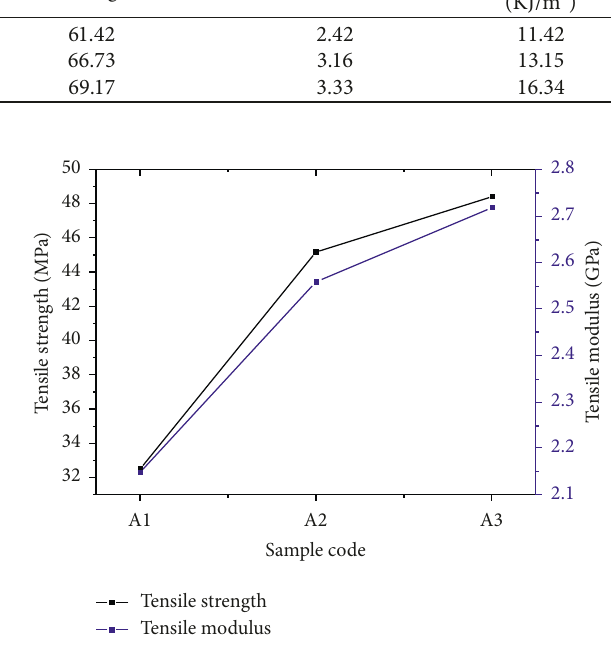
Figure 4: Tensile strength and modulus results.